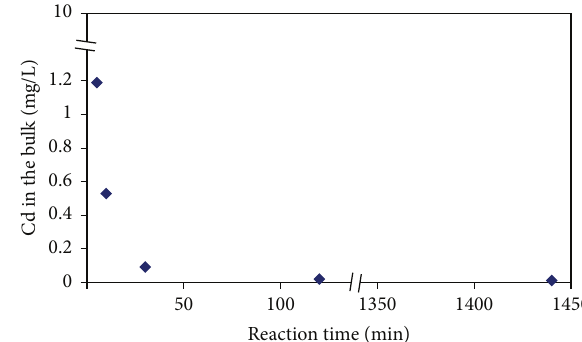
Figure 3: Time effect of Chelex-100 on cadmium species in BSA- cadmium